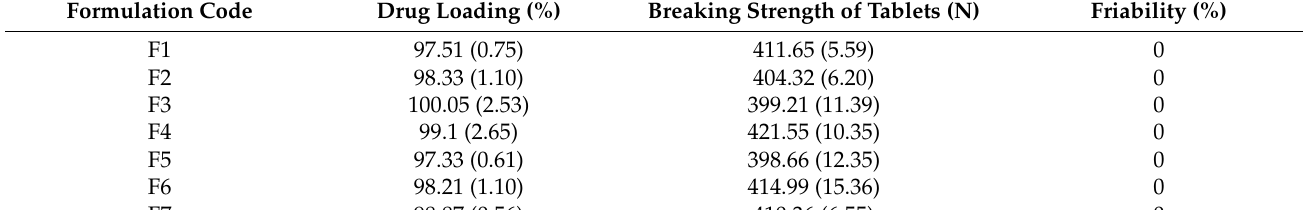
Table 3. Drug loading and mechanical properties of 3D-printed tablets.